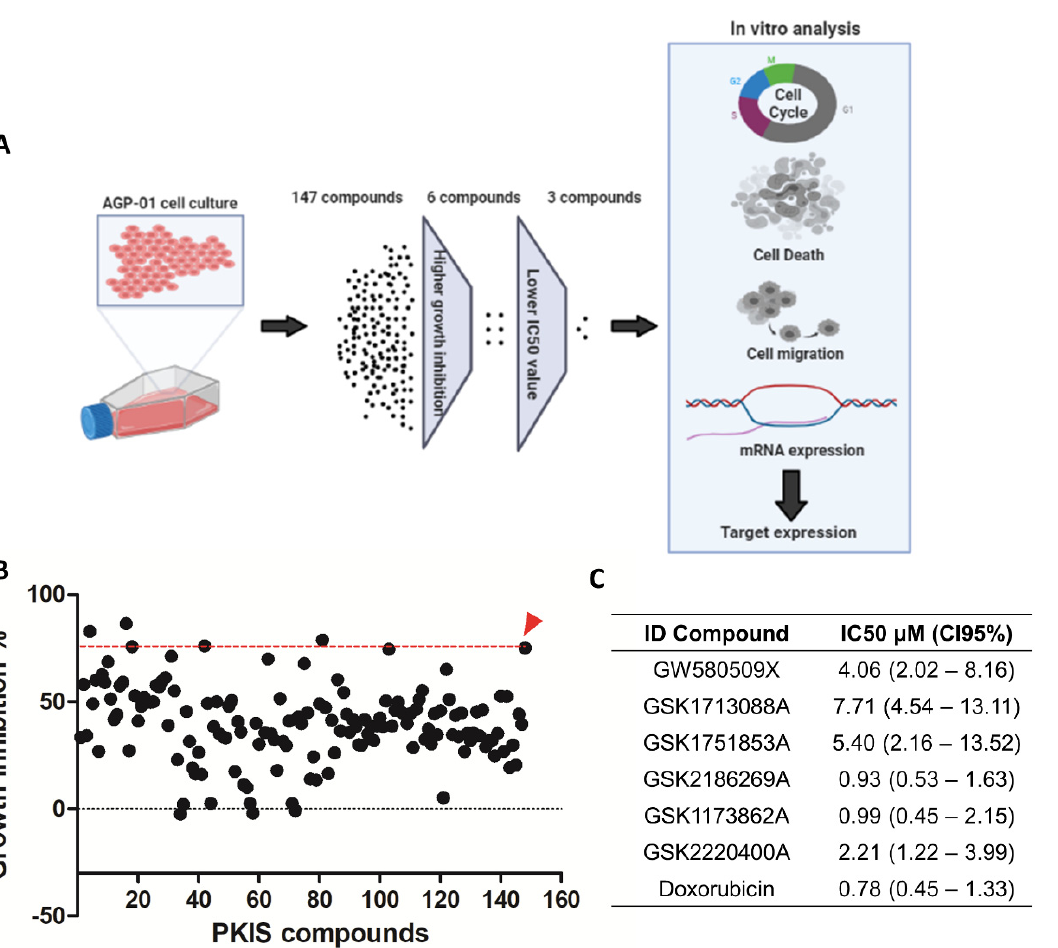
Figure 1. Cytotoxicity of 147 published kinase inhibitor set (PKIS) against metastatic gastric cancer cells (AGP-01). ( A ) Experimental design. After exposure to 147 published kinase inhibitors set (PKIS), only three kinase inhibitors were selected for further analyses based on their highly cytotoxic effect (lowest IC 50 values). ( B ) Growth inhibition normalized by the untreated control (DMSO) of 147 kinase inhibitors after 72 h of treatment. The red head arrow represents the positive control doxorubicin. ( C ) IC 50 values obtained from non-linear regression of curve concentration-response for the kinase with IC 50 values higher than